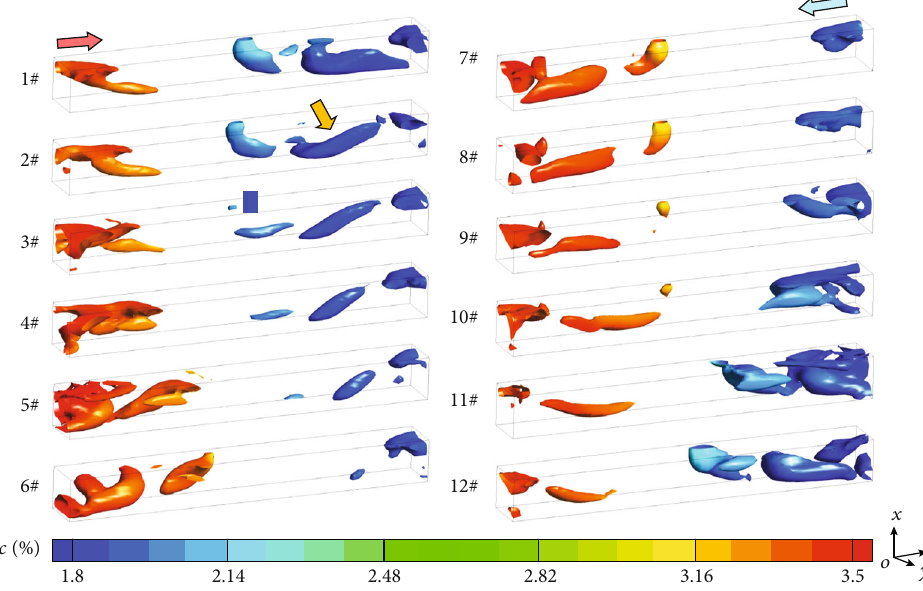
Figure 11: Q criterion isosurface ( Q = 0 : 03 ) colored by salinity magnitude in V-RERD.